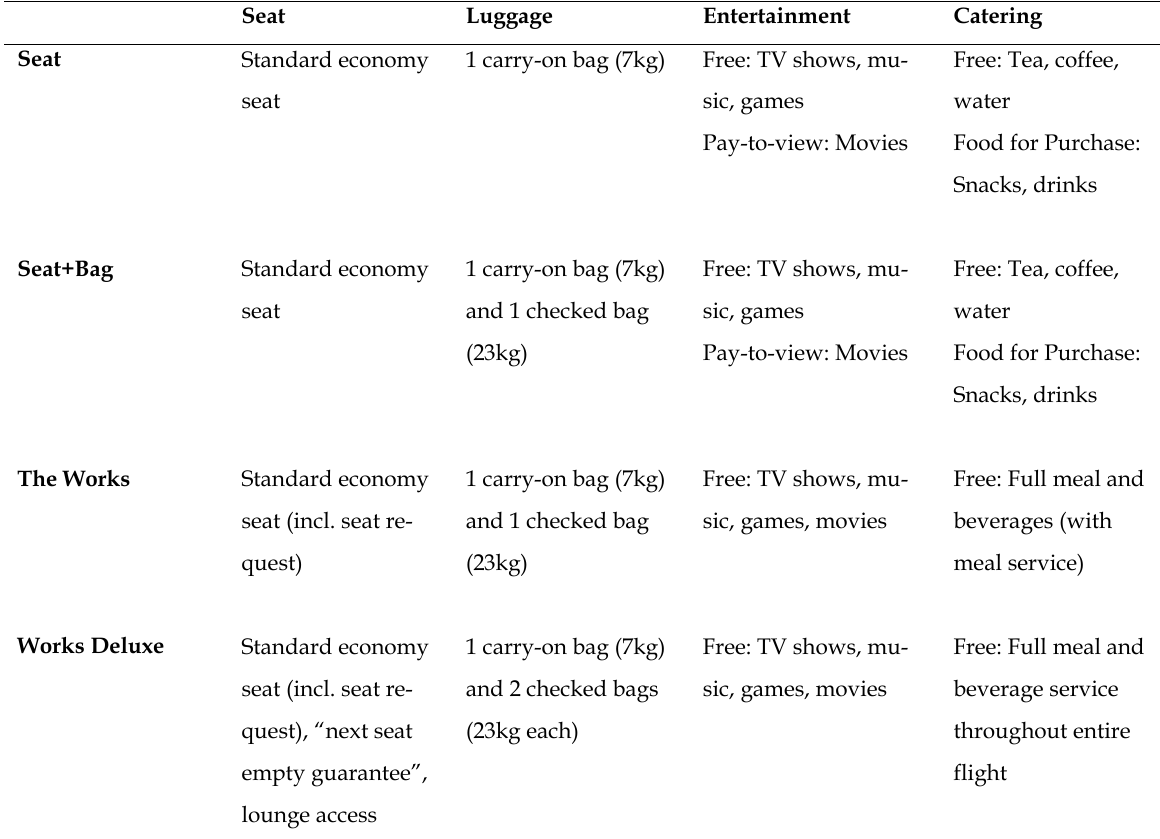
Table 9. New Air New Zealand Trans-Tasman Fares (to be gradually introduced from August 2010)